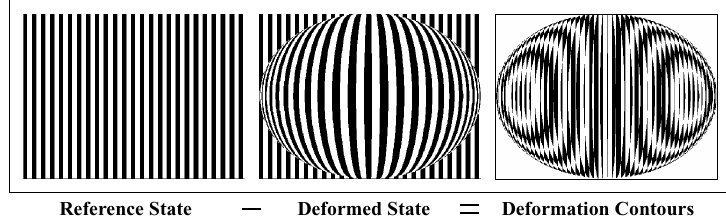
Fig. 1. Projection moir´e difference contouring.